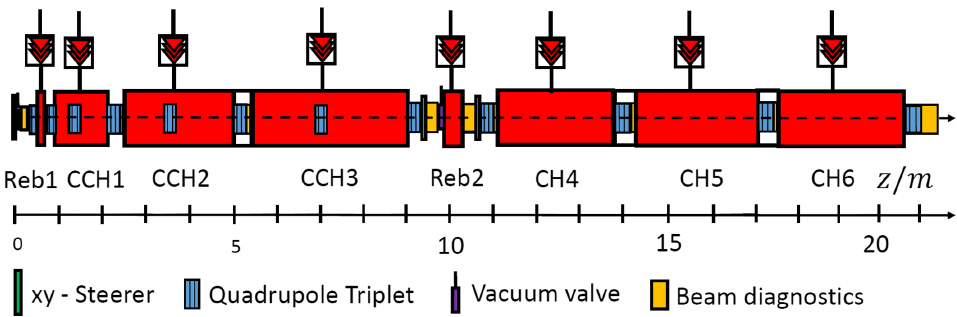
FIG. 18. Scheme of the 65 MV GSI/FAIR proton DTL with main